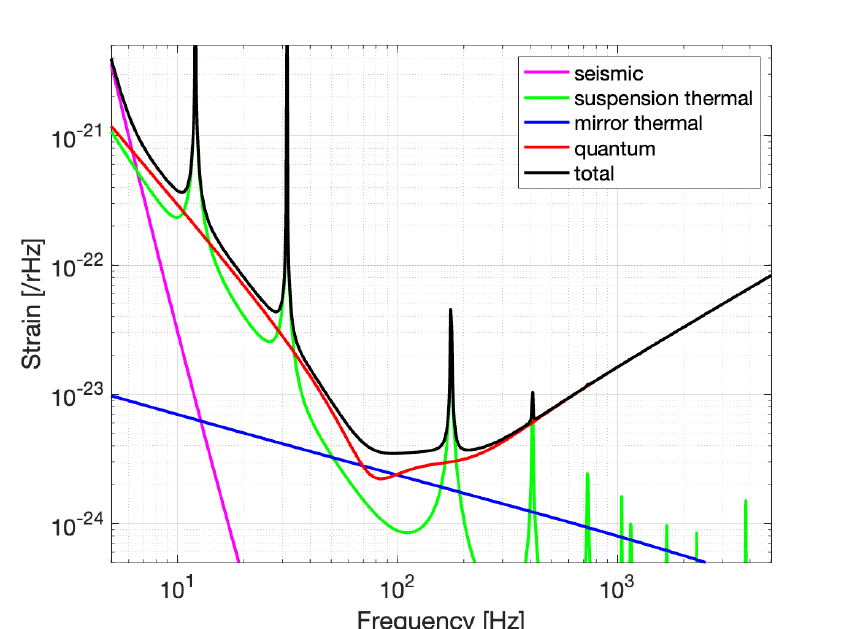
Figure 3. Design sensitivity curve of KAGRA [25]. The horizontal axis shows the frequency, and the vertical axis shows the detectable GW signal amplitude. Several fundamental noises are shown: seismic noise, mirror and suspension thermal noise, and quantum noise. Quantum noise is shown as the sum of the quantum radiation pressure noise and shot